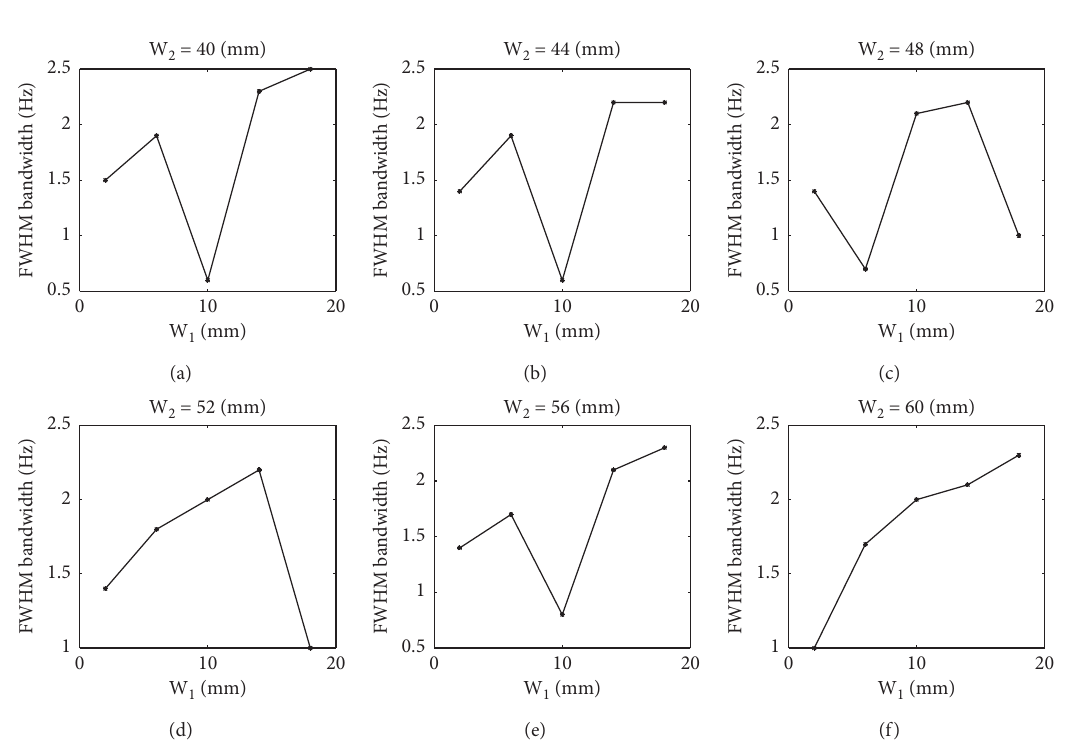
Figure 13: Real electrical power density FWHM bandwidth of 30 geometries of the two-piece trapezoidal composite piezoelectric bimorph beam (first design) in a closed circuit with corresponding optimal resistor load fixed. The length of the beam L is 60mm, the thickness of T piezo is 0.3mm, and the thickness of the brass layer T s is